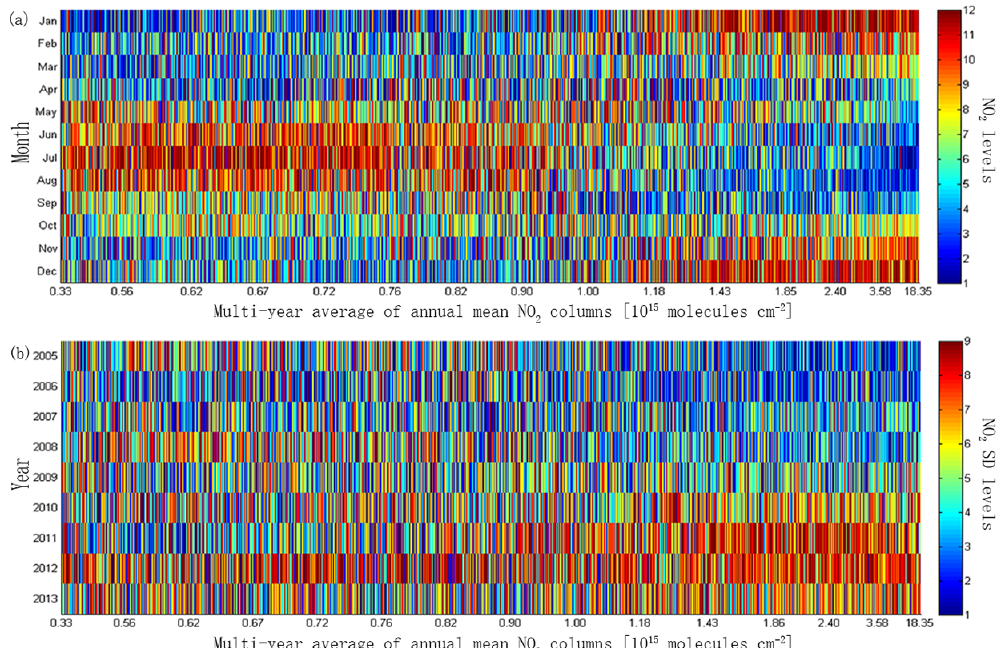
Figure 2. (a) 2005–2013 average seasonal variation of OMI NO 2 VCDs for each 0.25 ◦ × 0.25 ◦ grid cell of Western China; the grid cells are sorted by their 9-year average NO 2 VCDs. For each grid cell, the 9-year average monthly NO 2 values are converted to their reverse ranks (from 1 to 12; 1 represents the smallest NO 2 value). (b) Standard deviation (SD) of monthly OMI NO 2 VCDs in individual years over 2005–2013 for each 0.25 ◦ × 0.25 ◦ grid cell of Western China; the grid cells are sorted by their 9-year average NO 2 VCDs. For each grid cell, the seasonal SDs in the 9years are converted to their reverse ranks (from 1 to 9; 1 represents the smallest SD